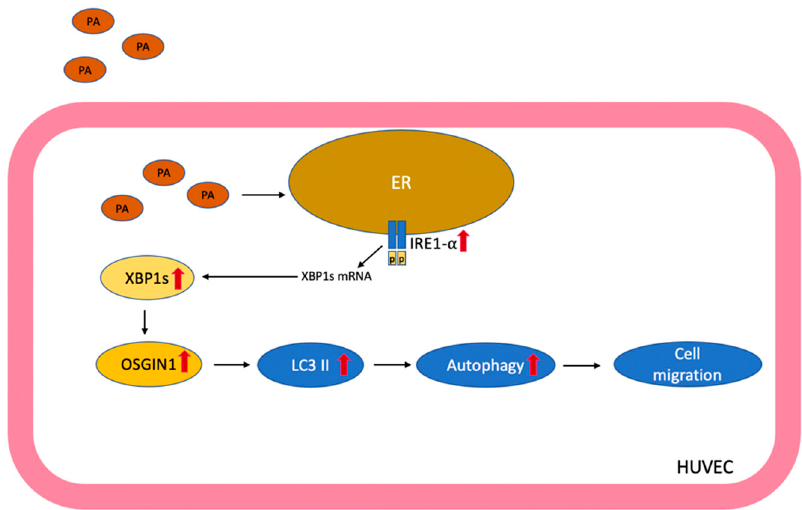
Figure 7. Schematic diagram depicting that the mechanisms for XBP1s regulates OSGIN1 and protects endothelial cells from PA-induced lipotoxicity. The accumulation of PA initiated UPR in endo- thelial cells; meanwhile, PA activated the IRE1 α –XBP1 axis, leading to alternative XBP1 mRNA splicing, and the upregulation of the XBP1s protein. PA enhanced the expression of OSGIN1, which was regulated by XBP1s to maintain cell migration through autophagy under PA-induced vascular lipotoxicity.